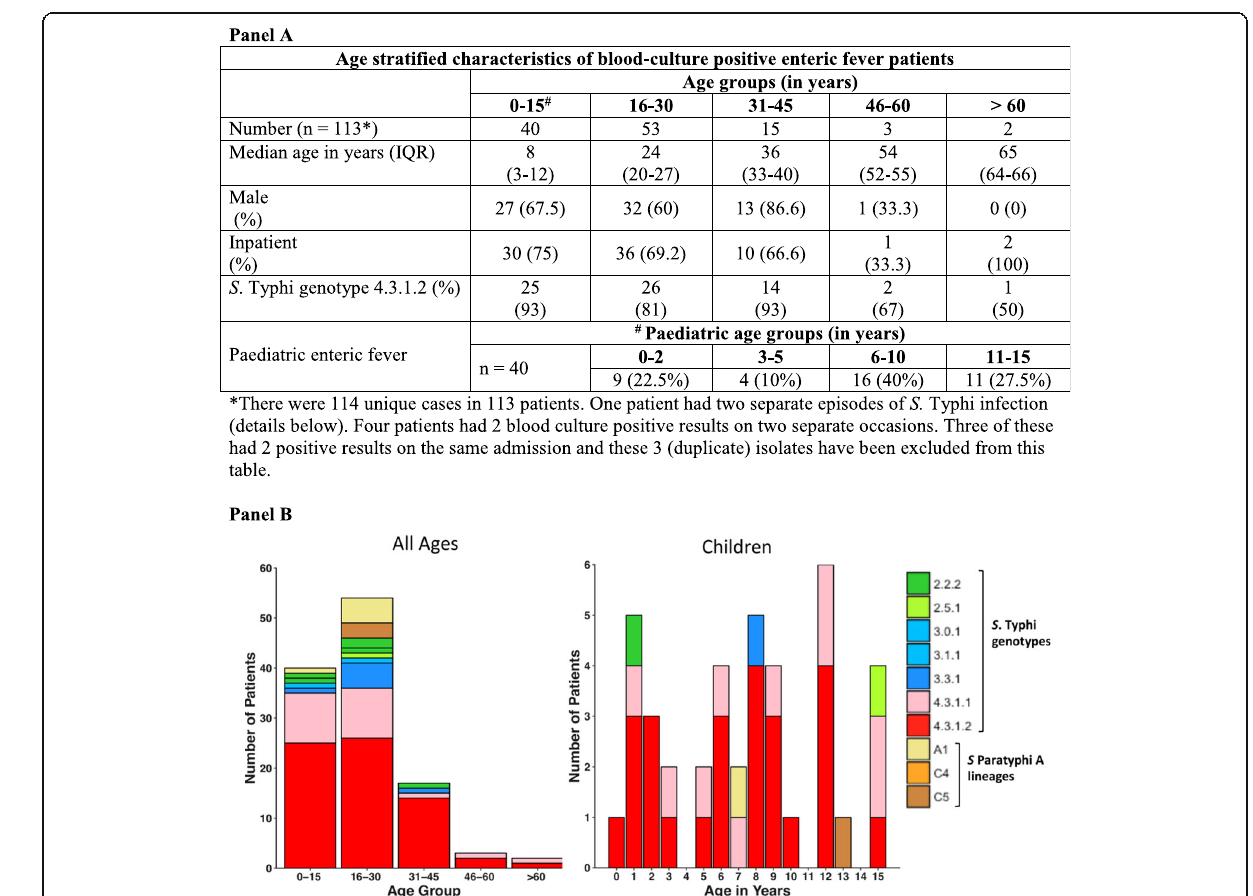
Fig. 1 Age-stratified distribution of typhoidal Salmonella genotypes. Indian S . Typhi genotypes stratified according to age group. Individual S. Typhi genotypes and S. Paratyphi A lineages are coloured as described in the inset